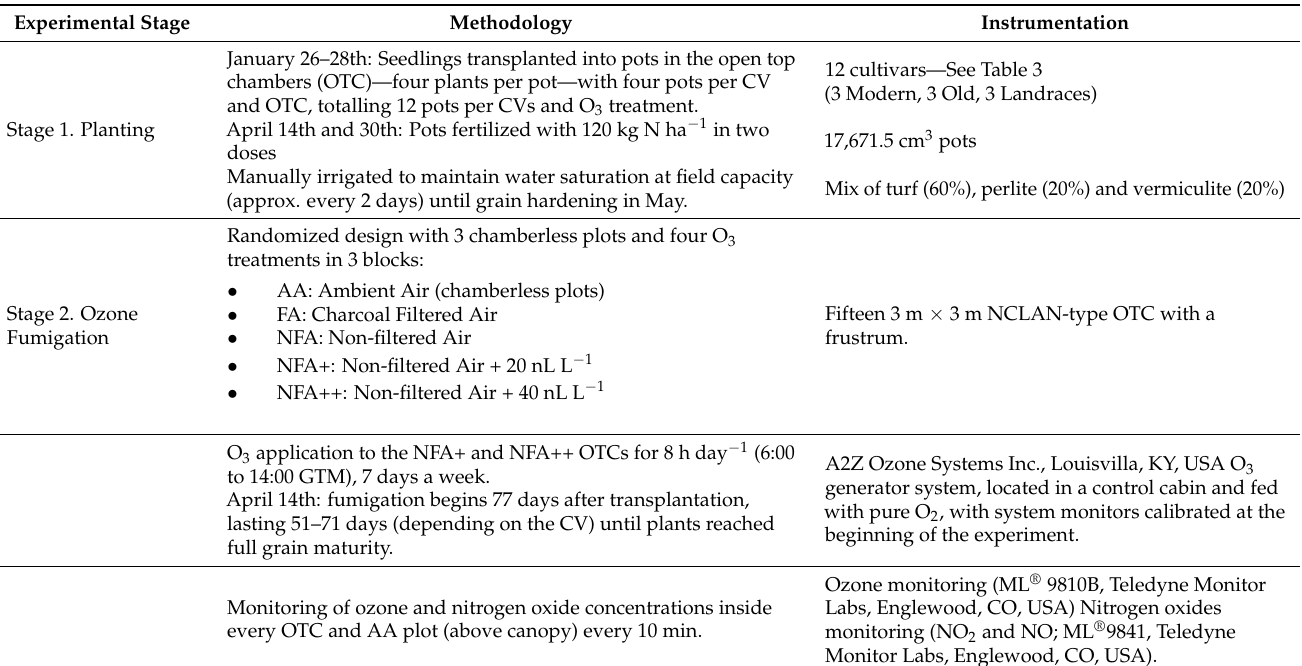
Table 2 summarizes the methodology and instrumentation for each experimental stage. Table 2. Summary of the experimental conditions and instrumentation used in the experiment per stage. Experimental